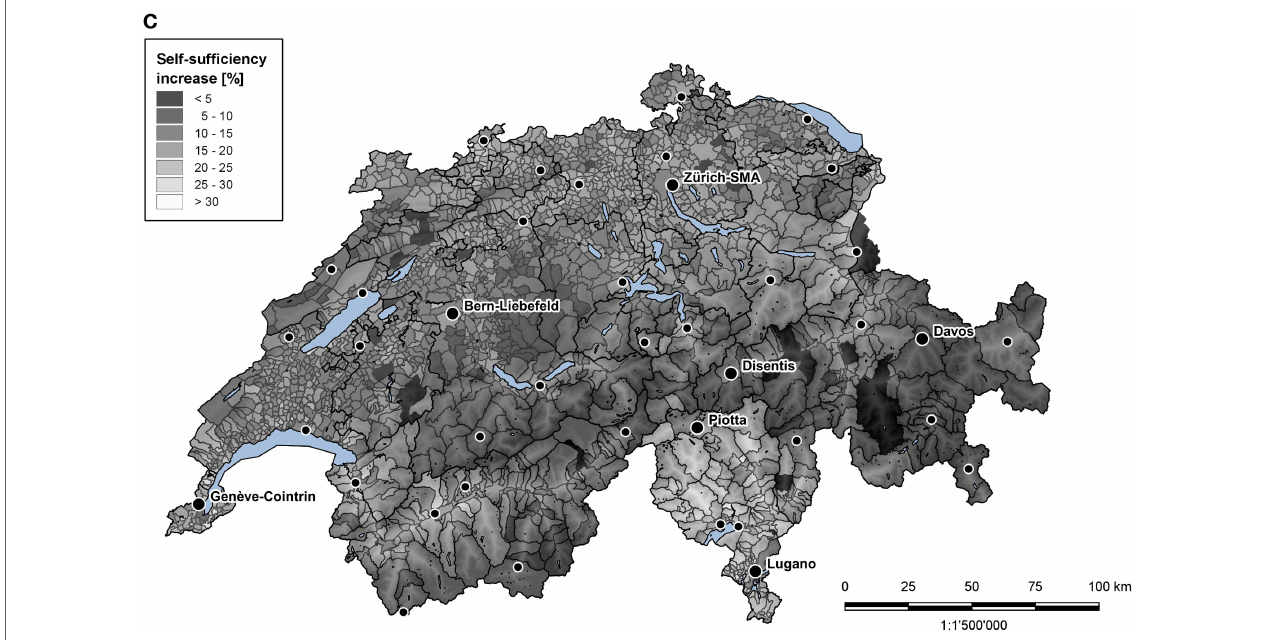
FIGURE 13 | Increase in self-sufficiency in each commune with the rise in capital expenses. (A) Solution 20. (B) Solution 30. (C) Solution 50.